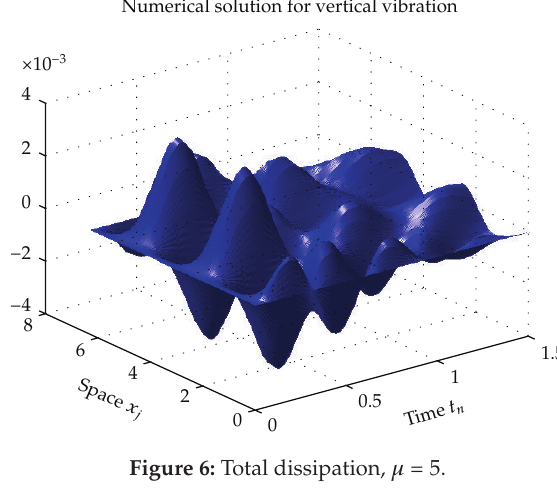
Figure 6: Total dissipation, μ (cid:8) 5.